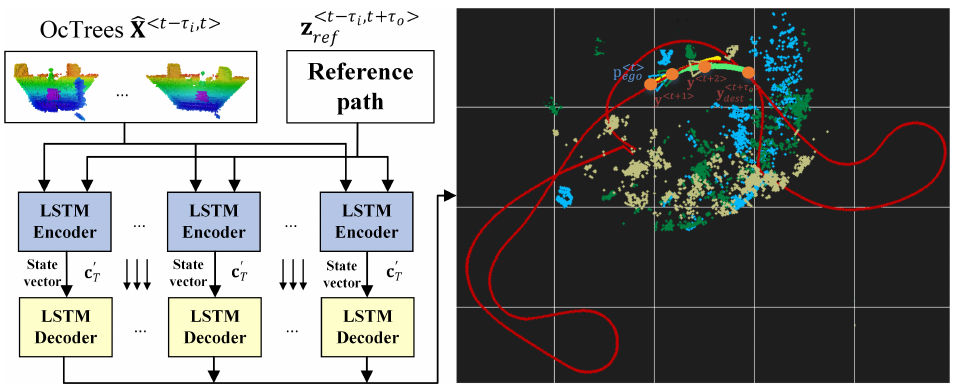
Figure 2. Estimating local trajectories for autonomous robots and vehicles using encoder-decoder recurrent neural networks. Considering the current ego vehicle’s position p < t > ego , an input sequence of octrees X < t − τ i , t > = [ x < t − τ i > , . . . , x < t > ] , the current sequence from the reference route z < t − τ i , t + τ 0 > ref and a desired destination from the reference path y < t + τ 0 > , the aim is to estimate a driving trajectory dest ] Y < t + 1, t + τ 0 > = [ y < t + 1 > , . . . , y < t + τ 0 > dest